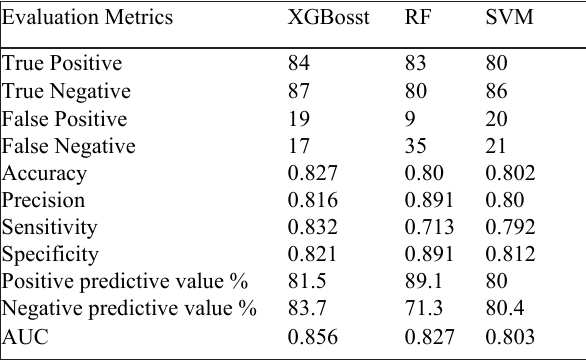
Table 4. Model performances estimated with validating samples.